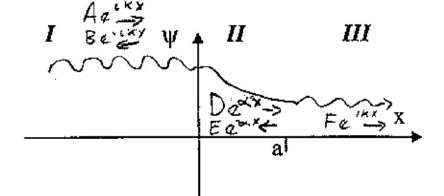
FIG. 13. Student response to tunneling question. A mixture of correct and incorrect ideas is applied in contradictory fashion. Dif- ferentiation has not yet